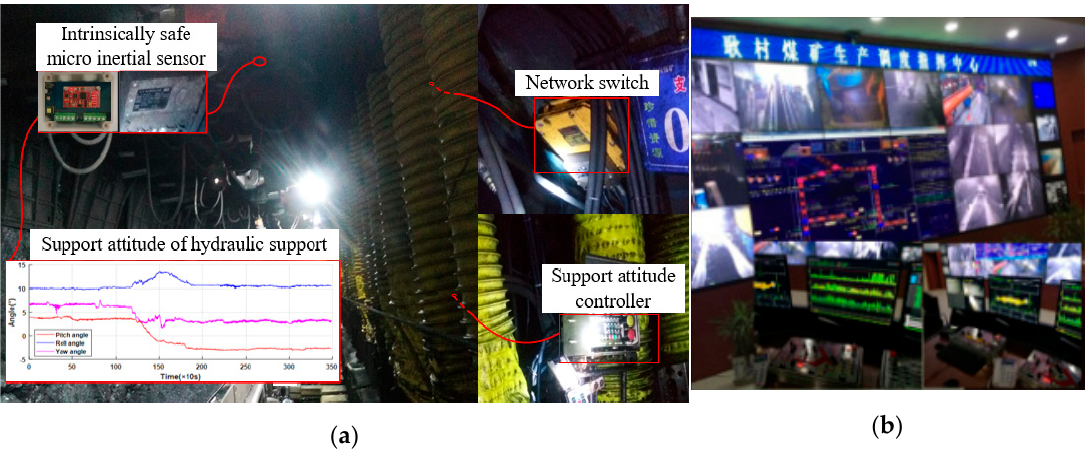
Figure 9. Industrial application of the support attitude sensing system: ( a ) application environment; ( b ) remote monitoring center.